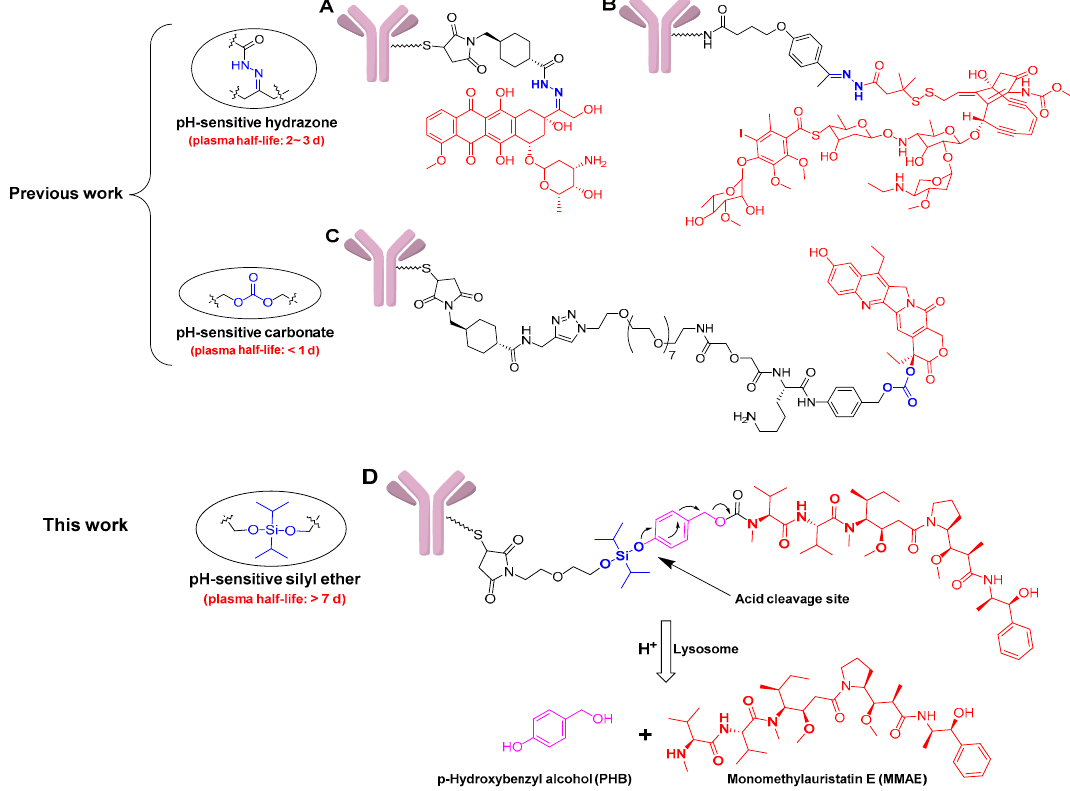
Figure 1. Structures of the chemically labile antibody-drug conjugates (ADCs) with acid-cleavable linkers, and the drug release mechanism of ADCs with monomethyl auristatin E (MMAE) as the payload. ( A ) The doxorubicin-based ADC with the pH-sensitive hydrazone linker; ( B ) the calicheamicin-based ADC with the pH-sensitive hydrazone linker; ( C ) the SN-38-based ADC with the pH-sensitive carbonate linker; ( D ) the designed MMAE-based ADC with the pH-sensitive silyl ether linker, and its drug release mechanism.